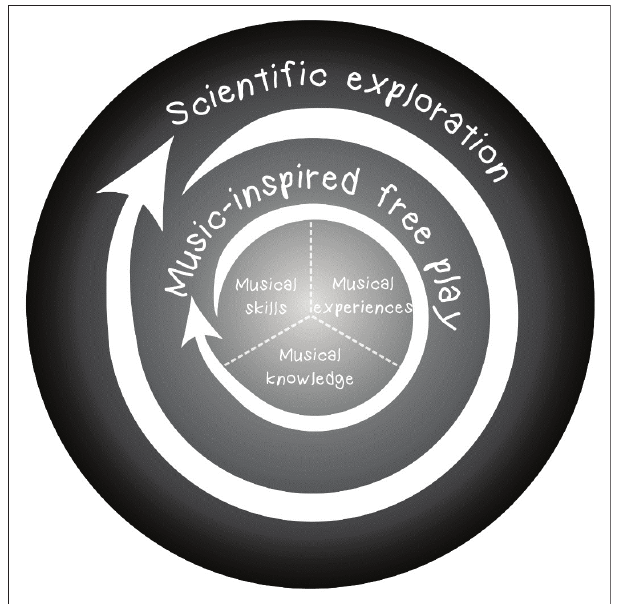
FIGURE 3: A conceptual model for music-inspired free play to foster scientific exploration in the early